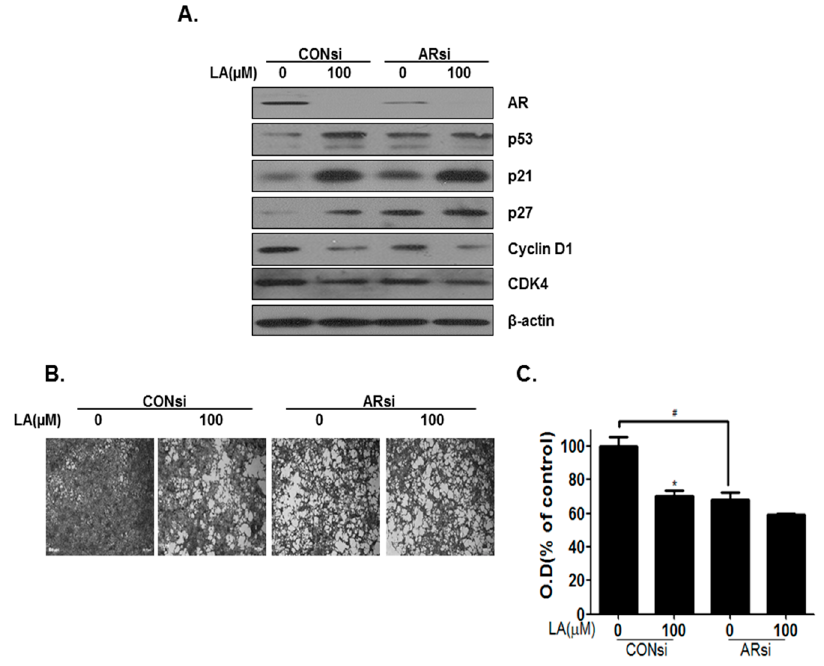
Figure 4. Effect of silencing androgen receptor (AR)-induced proliferation in LNCaP cells. ( A ) LNCaP cells were transfected with AR-siRNA for 24 h, treated with LA (0 and 100 μ M) for 24 h and then analyzed using Western blot; ( B ) Anti-proliferative activity following silencing of AR was evaluated using the cell growth assay. LNCaP cells were transfected with AR siRNA for 24 h, treated with LA (0 and 100 μ M), and incubated for three days; ( C ) Cells were stained; randomly chosen fields were photographed and resolved in 70% ethanol after washing with distilled water, and absorbance was read using a microplate reader (590 nm). # p < 0.05 and * p < 0.05 (in comparison to the control).